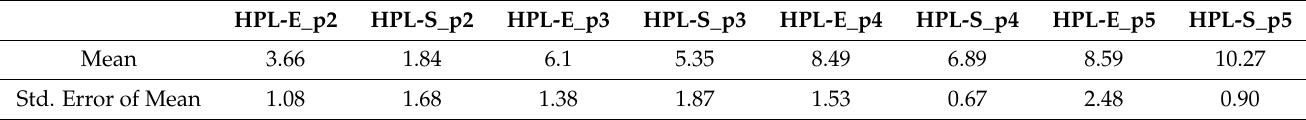
Table 2. Cumulative PD of BM-MSCs obtained at each passage during expansion in HPL-E and HPL-S. Data are expressed as means with the standard error of 5